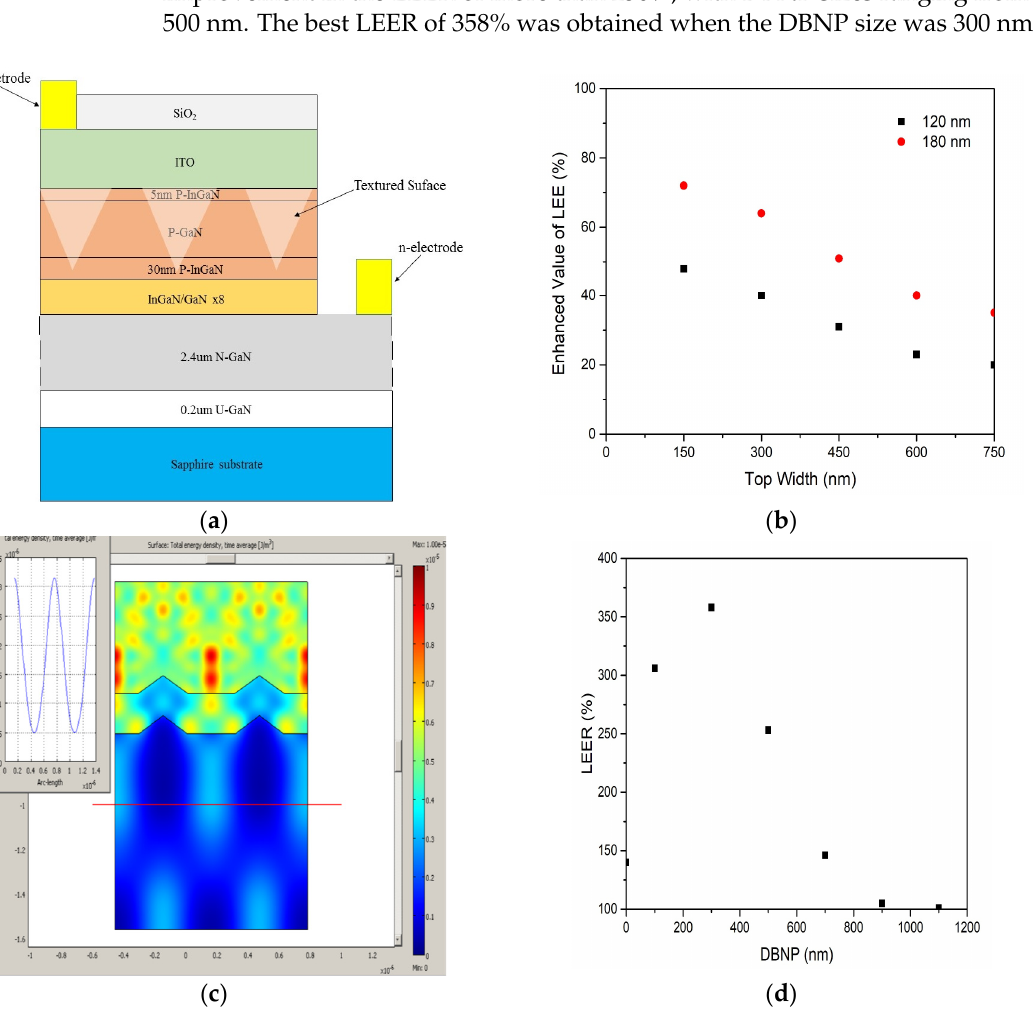
Figure 1. ( a ) Schematic diagram of a LED structure with textured surface. ( b ) Enhanced LEE values for LED0s, as simulated by FEM, with various top widths at depths of 180 nm and 120 nm when the p-GaN layer thickness is 300 nm. ( c ) Power intensity distribution as simulated by FEM for LED3. The power intensity value distribution at the red line is also clearly shown. ( d ) Effect of DBNP on LEER for